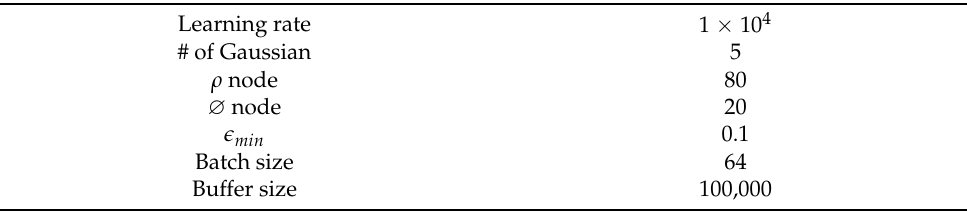
Table A2. DwGM-Q